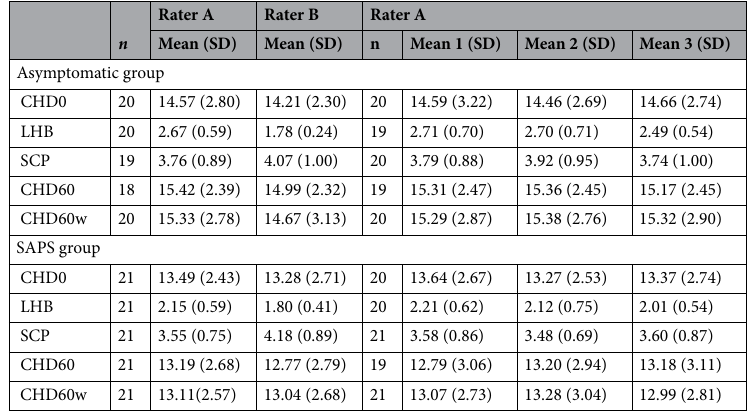
Table 1. US measures (in mm). The 3rd and 4th columns represent the means of three trials of rater A and B respectively. The 6th, 7th and 8th columns represent the first measure of rater A, second measure of rater A, third measure of rater A respectively. CHD0 coracohumeral distance at rest, CHD60 coracohumeral distance at 60°, CHD60w coracohumeral distance at 60° with weights, LHB long head of biceps tendon, n number of participants, SCP subscapularis